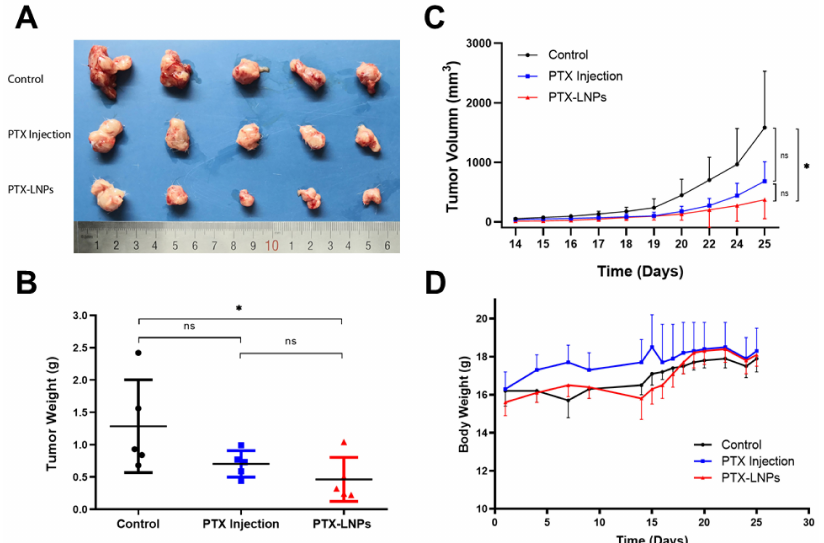
Figure 10. Anti-breast cancer efficacy of PTX-LNPs in 4T1 orthotropic mice. Notes: ( A ) images for the tumor of control, PTX injection and PTX-LNPs groups; ( B ) tumor weight statistics for the control, PTX injection, and PTX-LNPs groups; ( C ) variation of tumor volume for the control, PTX injection, and PTX-LNPs groups; ( D ) body weights for the control, PTX injection, and PTX-LNPs groups. ( n = 5) Abbreviations: PTX, Paclitaxel; PTX-LNPs, Paclitaxel lipid nanoparticles. Significant differences are indicated: * p < 0.05, ns (no significance). black bullet (Control), blue square (PTX Injection), red triangle (PTX-LNPs).